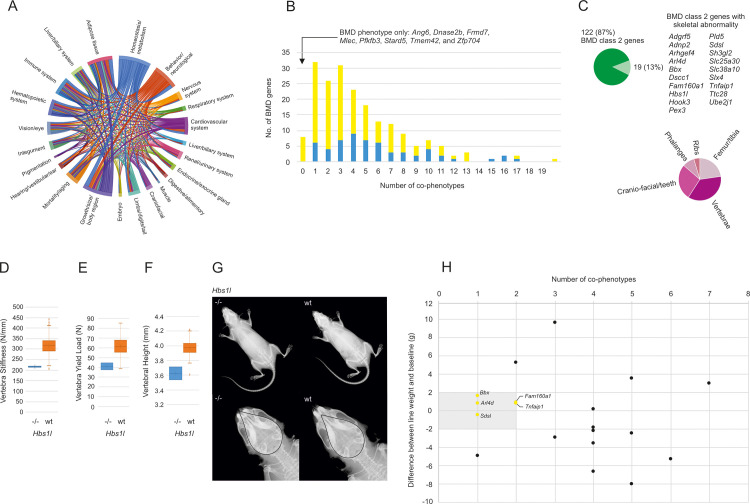
BMD genes were pleiotropic.(A) Chord diagram plotting the inter-connectivity of co-phenotypes associated with the 200 BMD genes. The outer segments represent the co-phenotypes grouped as top-level Mammalian Phenotype (MP) terms. The segment size correlates with the number of genes exhibiting the co-phenotype. Homeostasis/metabolism was the primary co-phenotype detected. The size of the arcs connecting the phenotypes was proportional to the number of genes connected. Diagram colors were assigned clockwise starting with the primary phenotype. (B) The majority of BMD genes presented with up to 3 co-phenotypes, while eight genes were limited to a skeletal phenotype. Class 1 (known function in bone biology) and 2 (unknown function in bone biology) genes are distinguished in yellow and blue color, respectively. (C) Analysis of the IMPC phenotyping data showed that 19 of the 141 class 2 genes were also associated with skeletal abnormalities in addition to changes in BMD. Vertebrae abnormalities were the most frequent skeletal abnormalities associated with the deletion of one of the 19 genes. (D) OBCD data showed a difference in vertebra stiffness for Hbs1l compared to wt. (E) OBCD data detected a difference in vertebra yield load for Hbs1l compared to wt. (F) OBCD data measured a difference in vertebral height for Hbs1l compared to wt. (G) Dorsal images were taken from the IMPC x-ray screen. Representative female Hbs1l-deficient mice and wild type (wt) control mice are shown. In the upper panels, the position of the pubic body was denoted by a black line. In Hbs1l-/- mice, a distal shift of the pubic body intersection relative to the S1 sacral vertebra was seen (p<0.0001 for vertebrae abnormality in the Hbs1l-/- cohort versus wt mice). The two lower panels show a skull close-up on a second set of female animals. Identical outlines of the cranium were superimposed. Hbs1l-/- mice showed a compressed cranium including nasal bones (p<1x10-8 for vertebrae abnormality in the Hbs1l-/- cohort versus wt mice). (H) Among the 19 genes with both BMD change and skeletal abnormality, a limited weight difference compared to wt controls and a low number of co-phenotypes (gray shaded area) indicated genes more likely to directly affect the skeleton. All 19 genes were plotted, genes in the gray shaded areas were colored in yellow according to their class 2 designation.